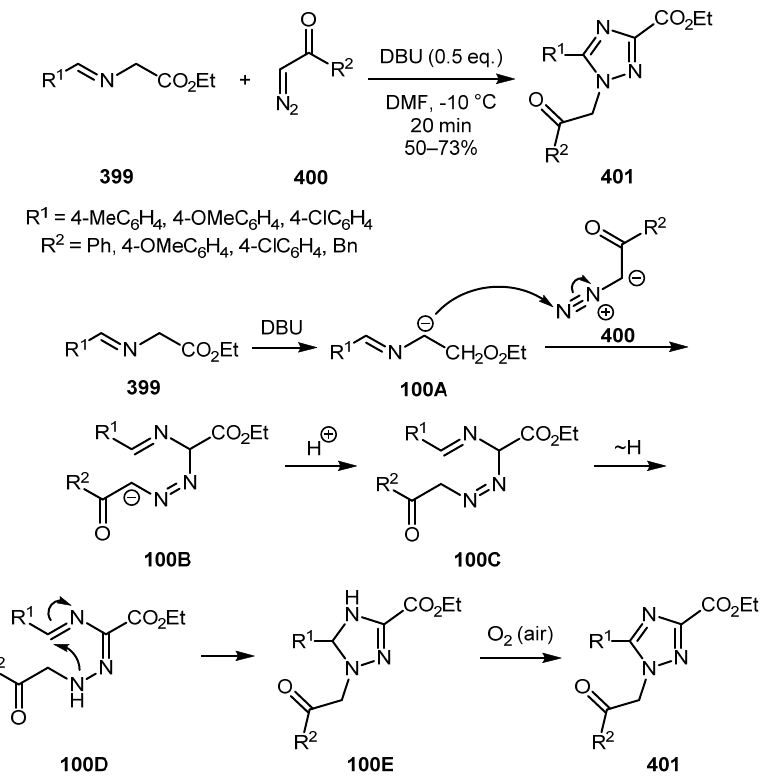
Scheme 100. DBU-promoted reaction of glycine imines with diazo ketones for the synthesis of 1,2,4-triazole-3-carbox-